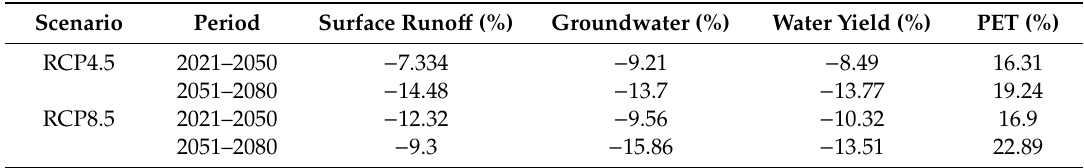
Table 7. Changes of water balance components under a climate change.